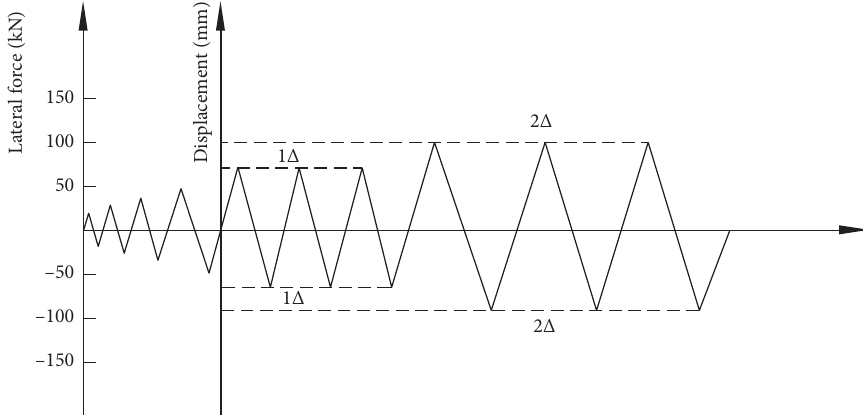
Figure 6: Lateral loading